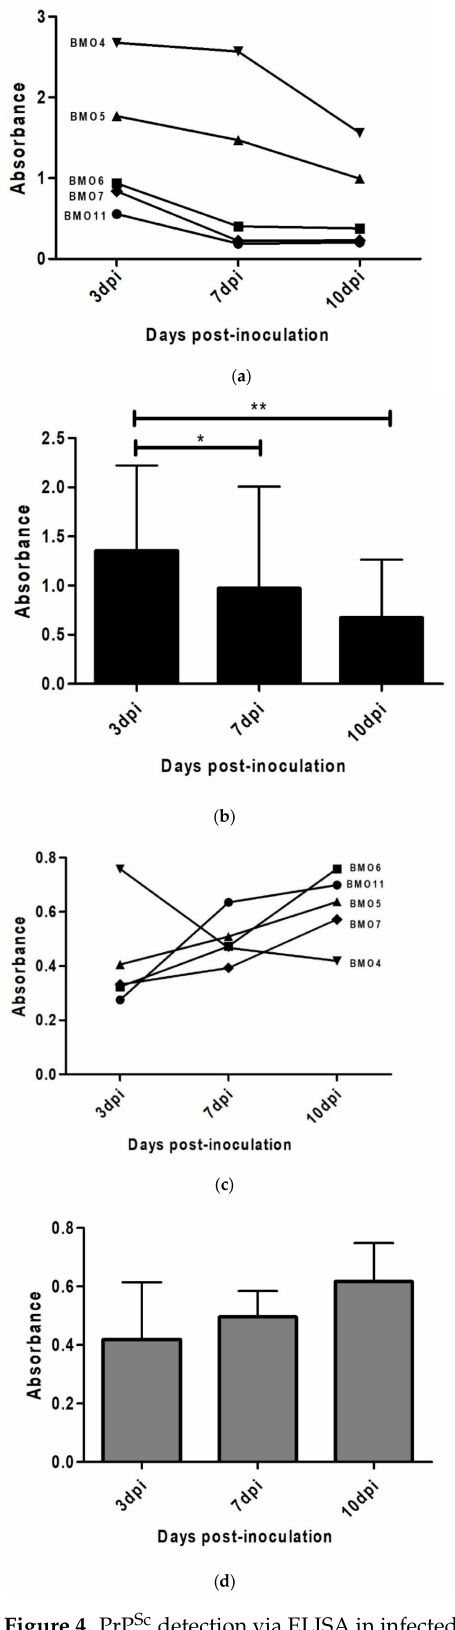
Figure 4. PrP Sc detection via ELISA in infected oBM-MSC cultures from 5 donors in growth ( a , b ) and neurogenic differentiation ( c , d ) conditions 3, 7 and 10 days post-inoculation (dpi). Significant differences were calculated using Student’s t -test (* p < 0.05, ** p <